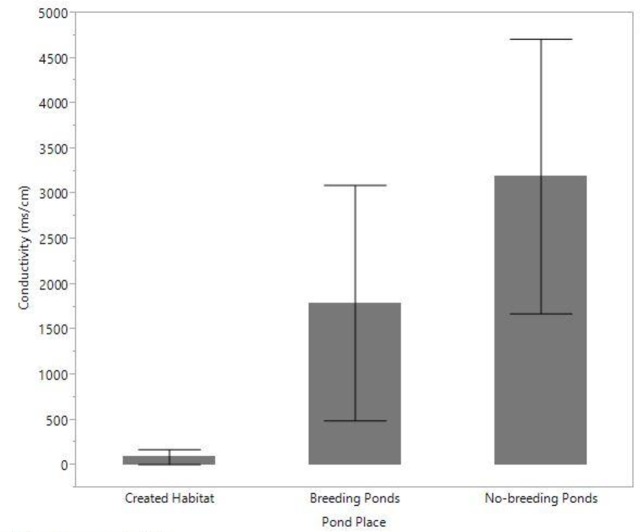
Mean pond conductivity across each of the pond places.Error bars represent 95% confidence intervals.